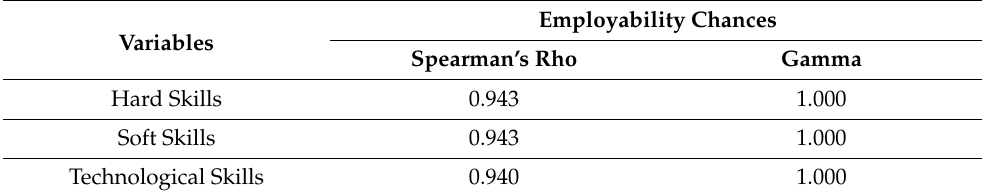
Table 8. Spearman’s Rho and Gamma value of variables.